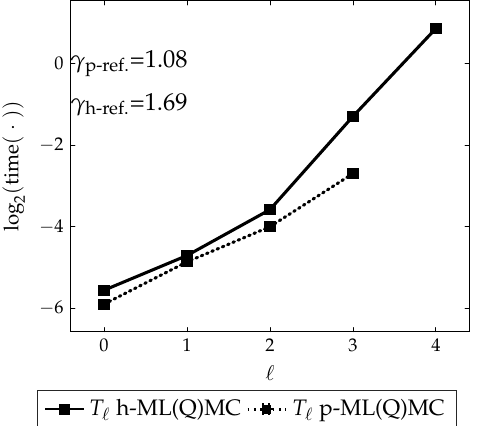
Figure 16. Times for one solve per level for model problem